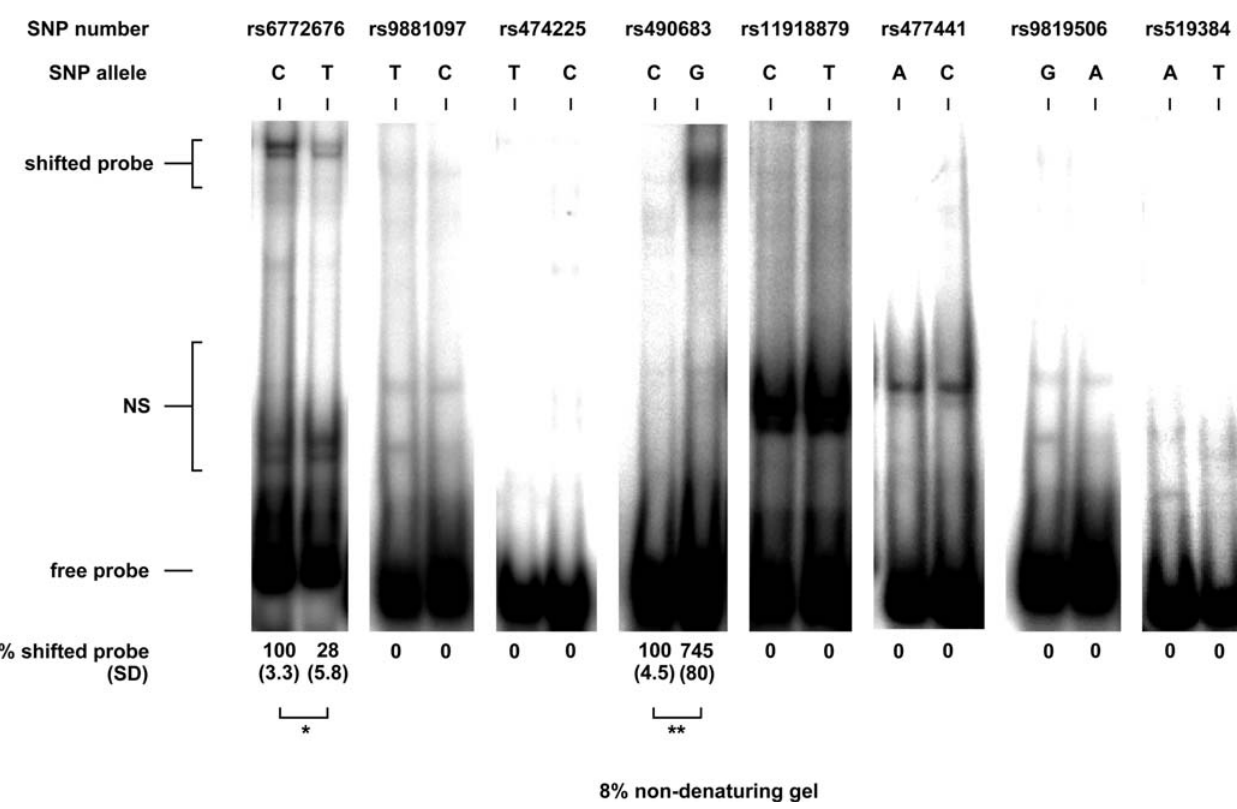
Figure 4. Differential protein binding of rat hypothalamus nuclear protein extract. Gelshift experiments were performed with 32 P-labeled oligonucleotides containing one or the other allele of respective single nucleotide polymorphism (SNP). Numbers below the gels indicate the means of three independent experiments with standard deviation (SD) in parenthesis. Protein binding of the ‘‘wild-type’’ allele was normalized to 100%. Representative gels are shown. NS denotes non-specific DNA-protein interactions, which are not due to specific binding between the labelled DNA and the proteins contained in the hypothalamus extract. * p , 0.05; ** p , 0.001.